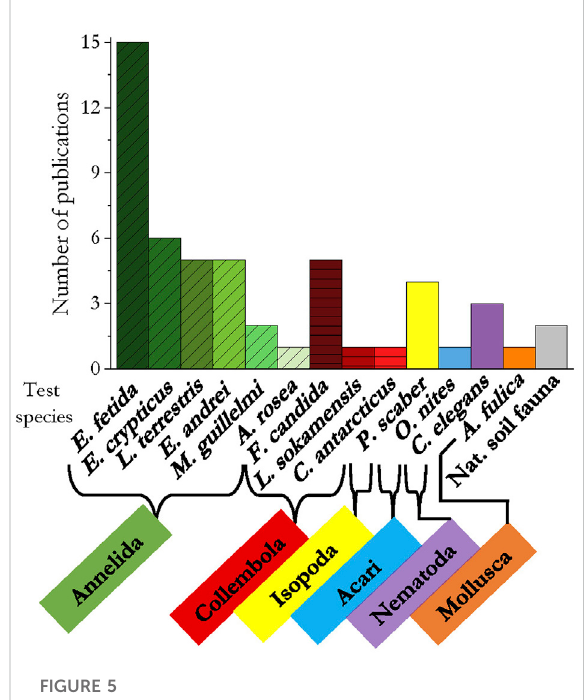
FIGURE 5 Test species per taxa used in the reviewed literature. Related colors of the species indicate af fi liation with the same